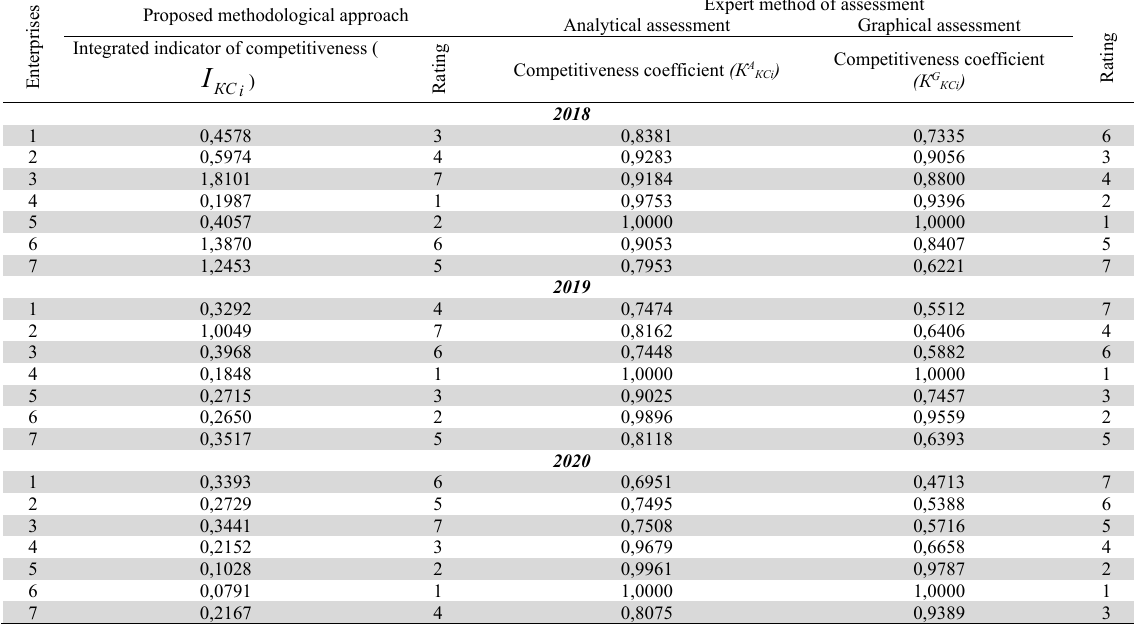
Proposed methodological approach